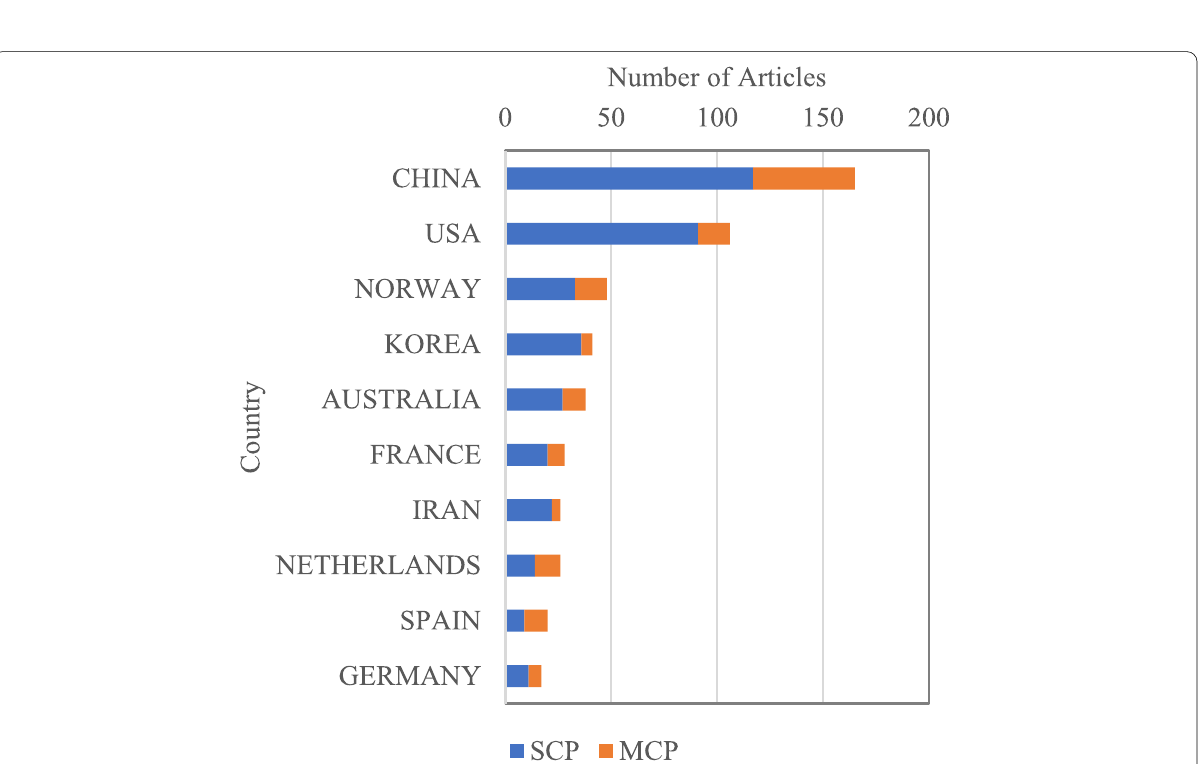
Fig. 20 Membrane, top contributing